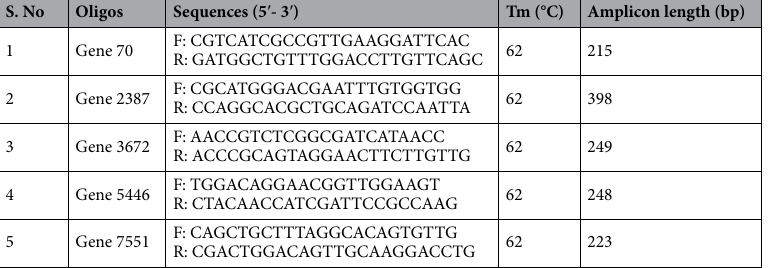
Table 4. List of primers used for quantitative expression analysis of the selected S. sclerotiorum effector